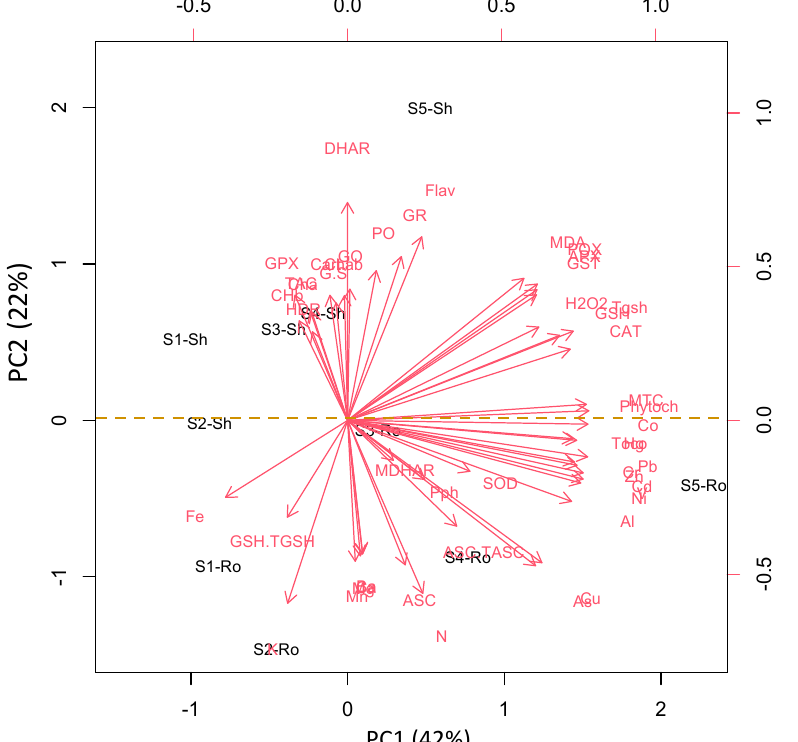
Figure 6. Principal component analysis (PCA) of parameters involved in photosynthesis, photorespiration, oxidative stress, detoxification, and antioxidant defense in the roots (Ro) and shoots (Sh) of S. portulacastrum grown in different control sites (S1) and contaminated sites (S2–5).